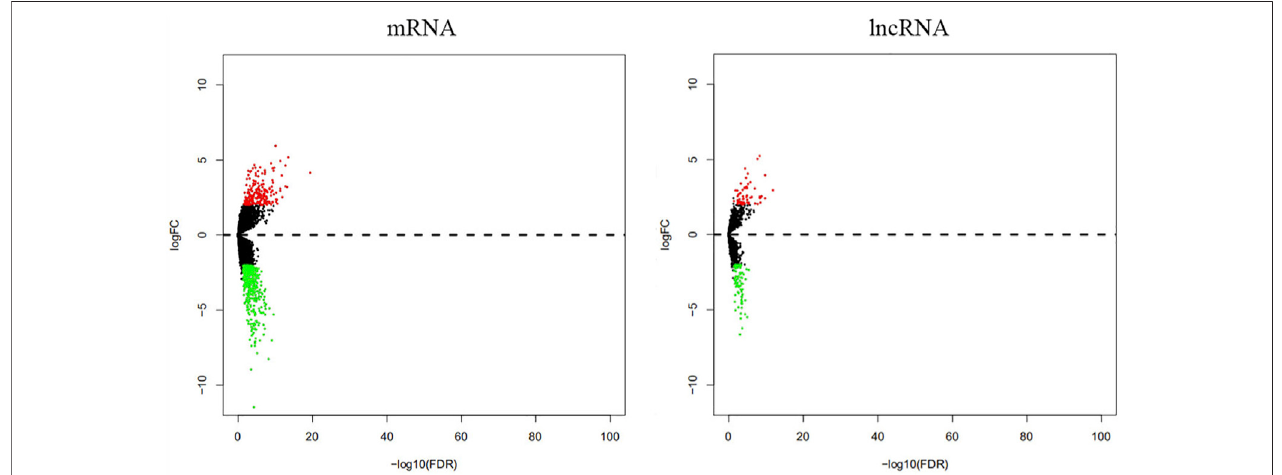
FIGURE 1 | Differential expression of mRNAs and lncRNAs between thymoma with MG and thymoma without MG.